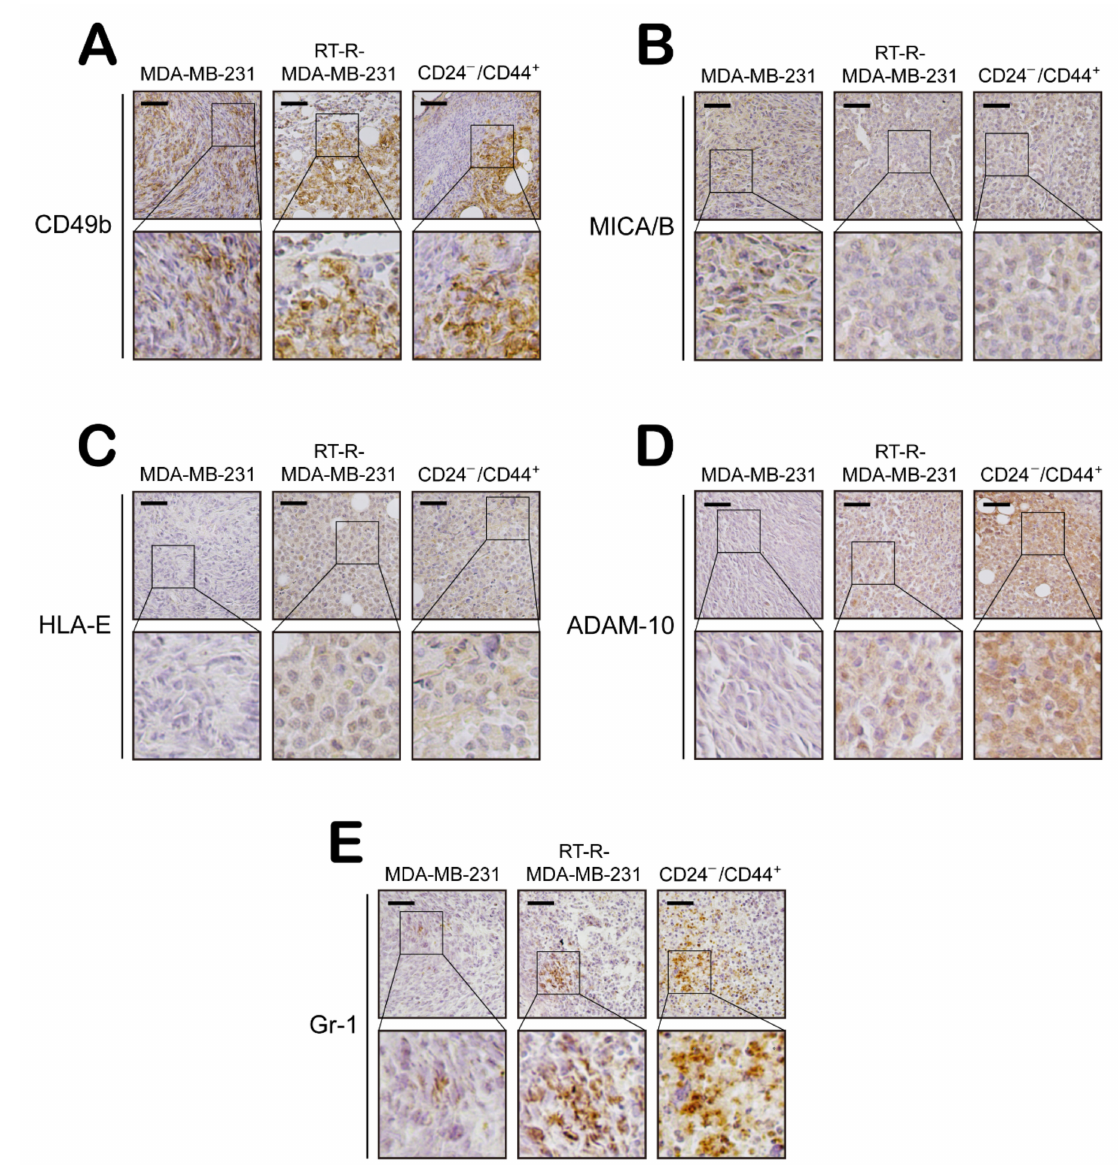
Figure 7. NK cells infiltrate tumor tissues but are functionally impaired through a reduction in the expression of the activating ligand MICA/B and induction of the inhibitory ligand HLA-E in CD24 − /low /CD44 + BCSC-injected mice. Tumor tissue sections from MDA-MB-231 cell-, RT-R-MDA-MB-231 cell-, and CD24 − /low /CD44 + BCSC-injected mice were immunohistochemically stained with antibodies specific for the indicated proteins: The murine NK cell marker CD49b ( A ), the NKG2D ligand MICA/B ( B ), the NKG2A ligand HLA-E ( C ), the MICA/B sheddase ADAM-10 ( D ), and the murine MDSC marker Gr-1 ( E ). Then, the stained sections were counterstained with Mayer’s hematoxylin solution. Scale bar: 100 µ